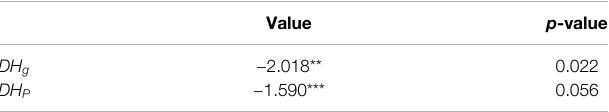
TABLE 5 | Westerlund (2008) panel cointegration